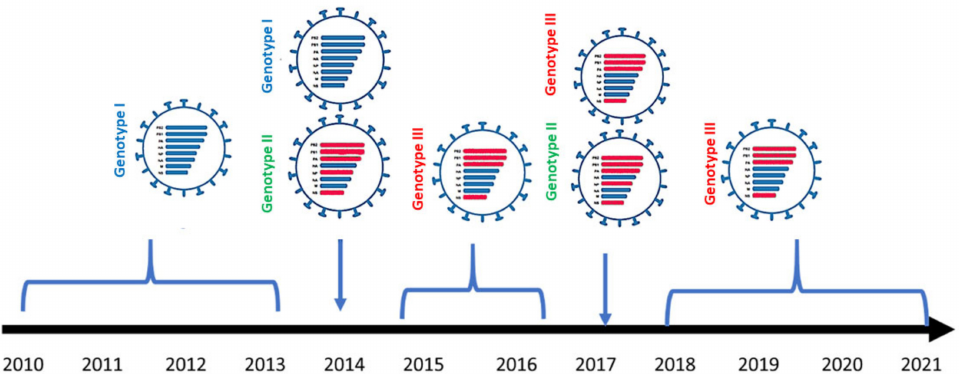
Figure 3. Schematic diagram showing genotypes and reassortment events of Egyptian H9N2 viruses by year (from 2010 to 2021). Blue bars indicate the first introduction form of H9N2 into Egypt, and the red bars indicate the segments that are derived from other subtypes of the Eurasian low pathogenic AI virus